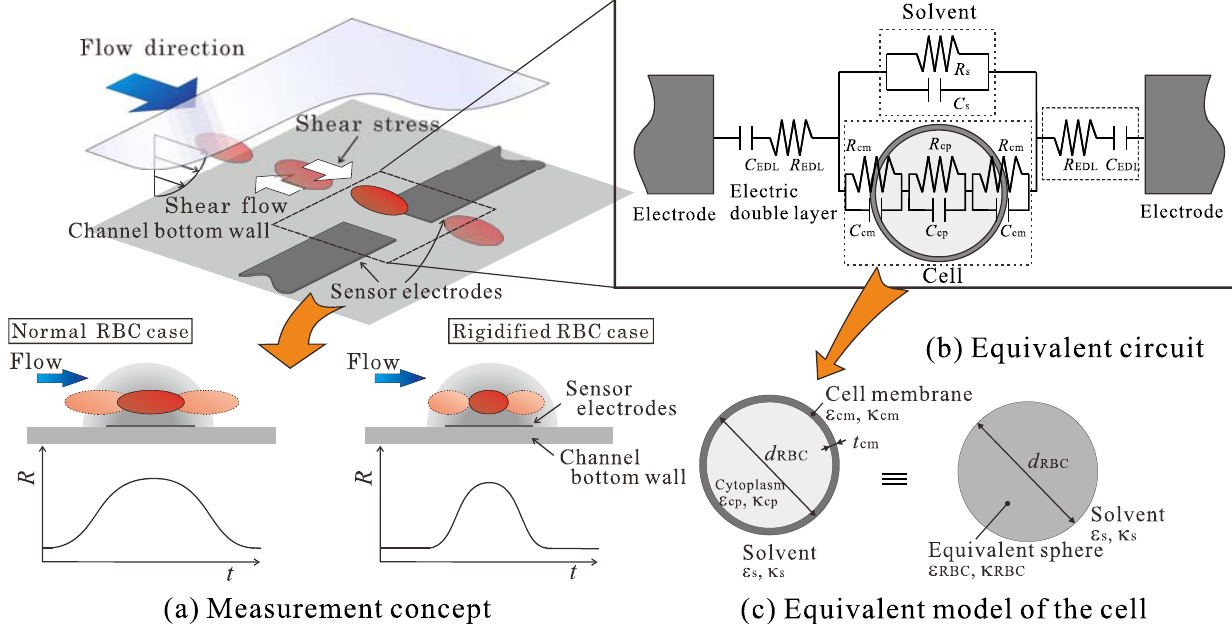
Figure 1. ( a ) Schematic views of the proposed method for measuring the RBC deformability; ( b ) equivalent circuit of the region between the electrodes; ( c ) equivalent model of a cell considered as a sphere with uniform complex